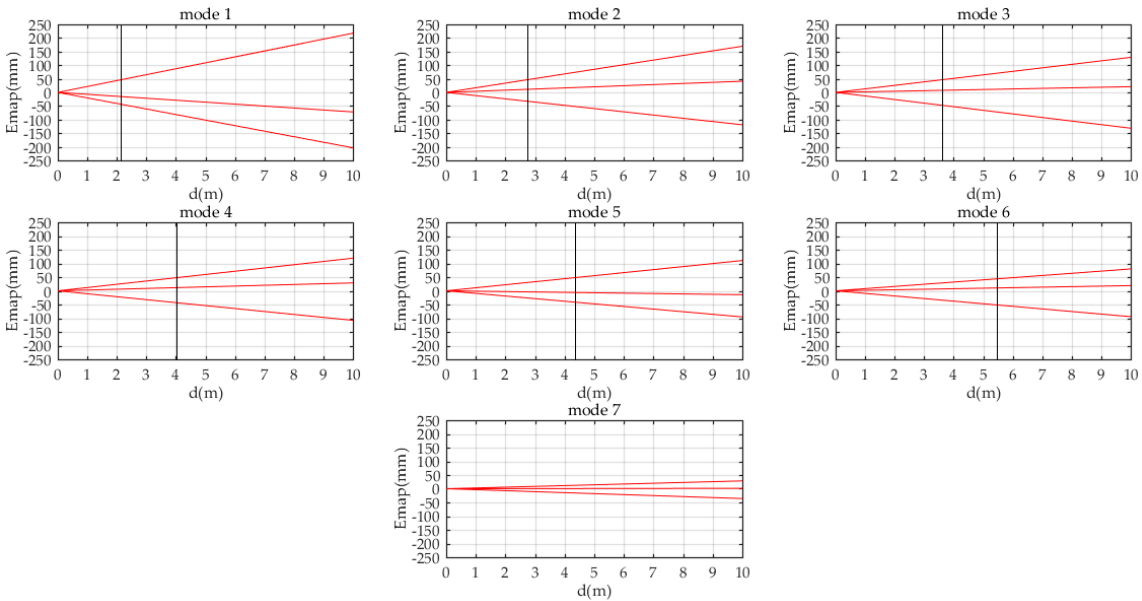
Figure 11. Variation curve of mapping error with distance in 7 modes.